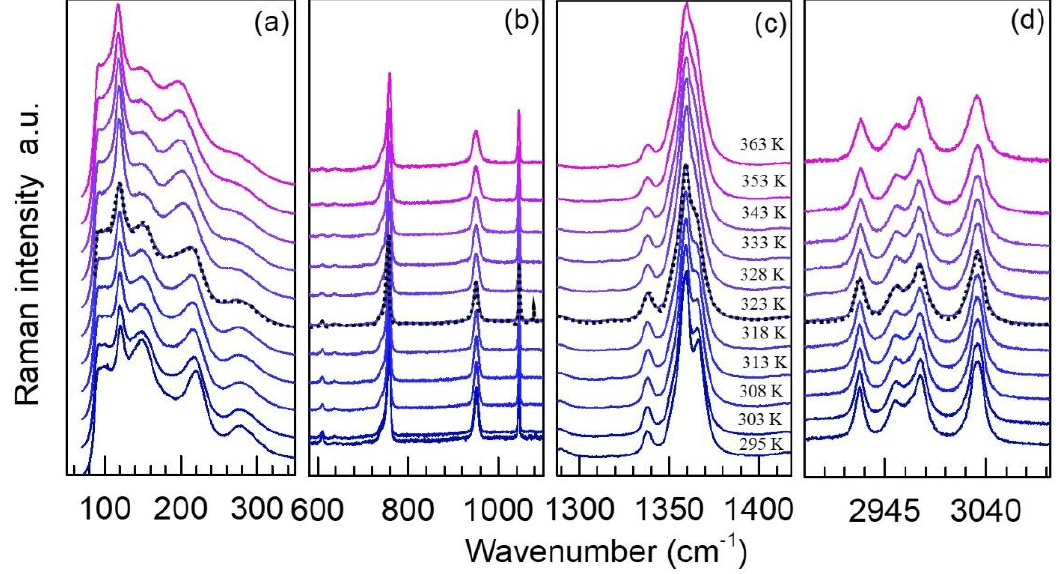
Figure 4. Representative Raman spectra of TMACdN 3 at selected temperatures in the region of ( a ) 30–350 cm − 1 , ( b ) 580–1110 cm − 1 , ( c ) 1287–1418cm − 1 and ( d ) 2901–3000 cm − 1 , normalized to the intensity of the highest peak and shifted vertically for better visualization and comparison. The dashed black line indicates the first-order ( γ → δ ) structural phase transition. In the other regions of the spectral range, as shown in Figure 5b,d, more subtle changes may be noticed and will be discussed below in more detail.